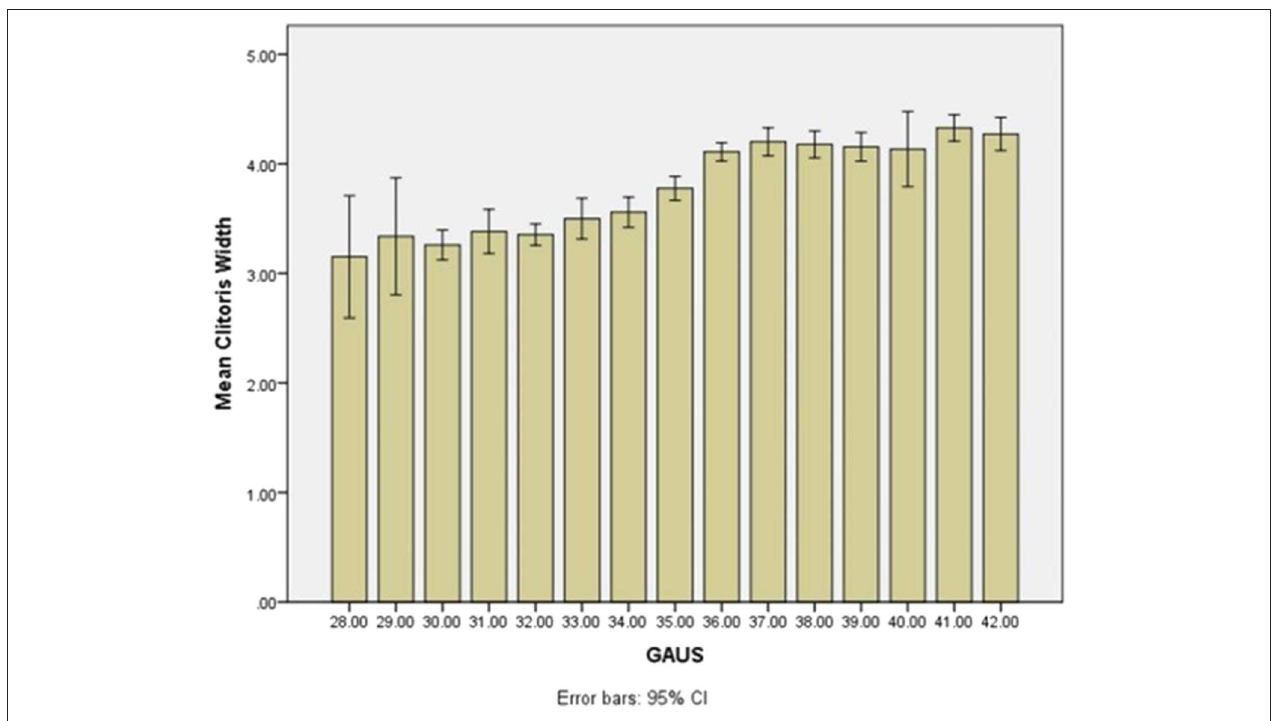
FIGURE 2 | Mean and SD of clitoral width based on different gestational ages of neonates.